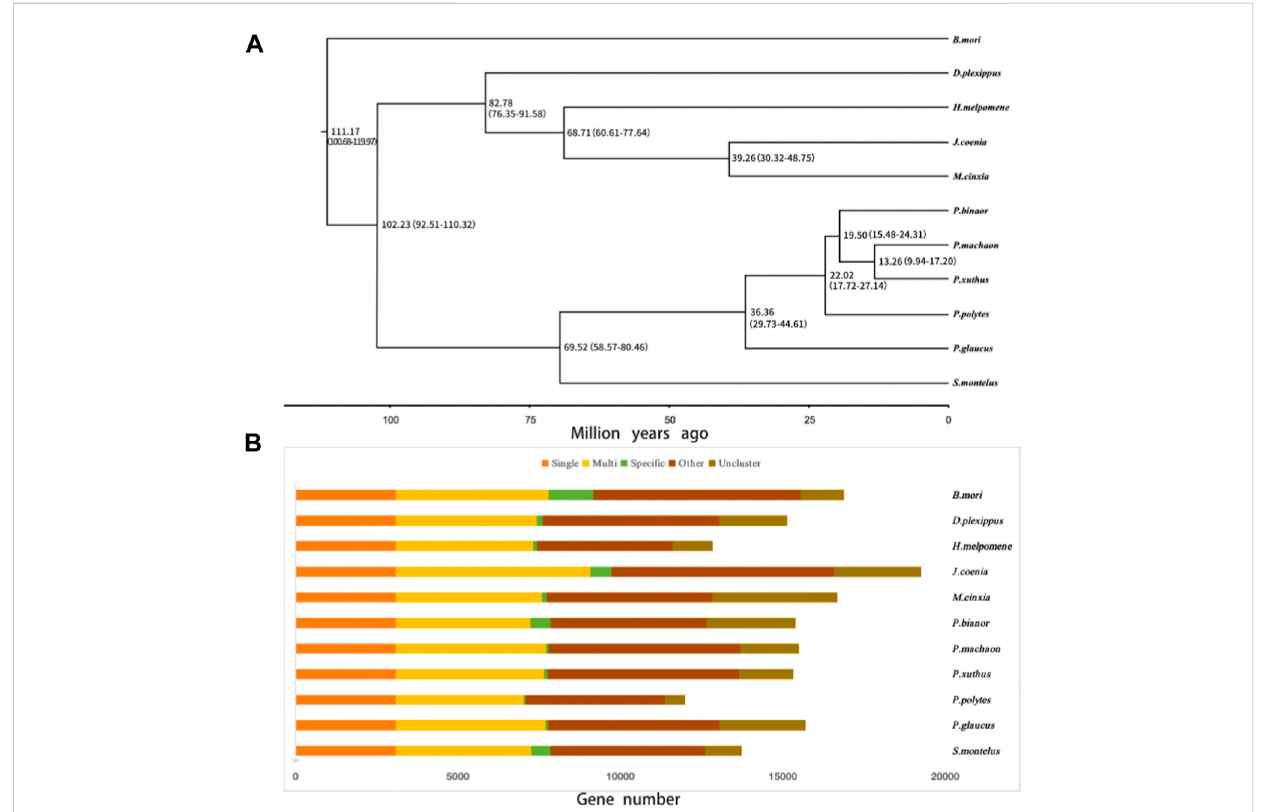
FIGURE 3 Phylogenetic tree and the orthogroup based on S. montelus and relative species. (A) Phylogenetic tree of S. montelu s with other species using 3071 single-copy ortholog genes. (B) Orthogroup between S. montelus and relative species. Single means single-copy orthologous genes; Multi means multiple-copy orthologous genes; Speci fi c means genes from a unique gene family; Other means genes that do not belong to Single, Multi, or Speci fi c; and Uncluster means unclustered genes.